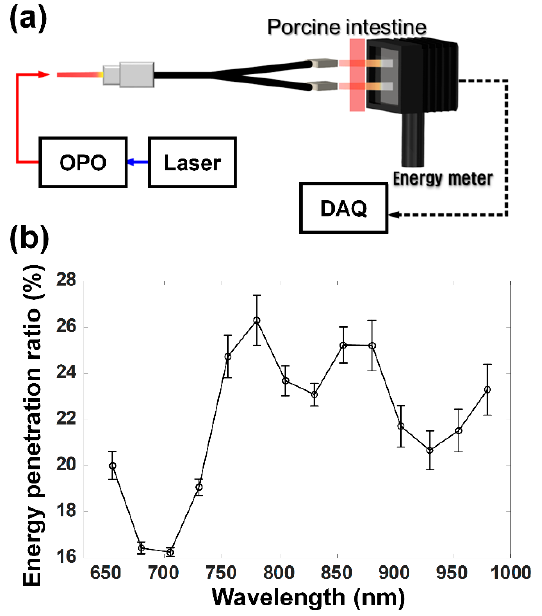
Figure 10. ( a ) Illustration of the experimental setup for measuring laser penetration through the porcine intestine and ( b ) ratio of laser energy penetration as a function of wavelength, which was obtained after measuring laser energy, both with and without the porcine intestine. The circles and the error bars indicate the mean and the variation. OPO and DAQ stand for optical parametric oscillator and data acquisition, respectively.